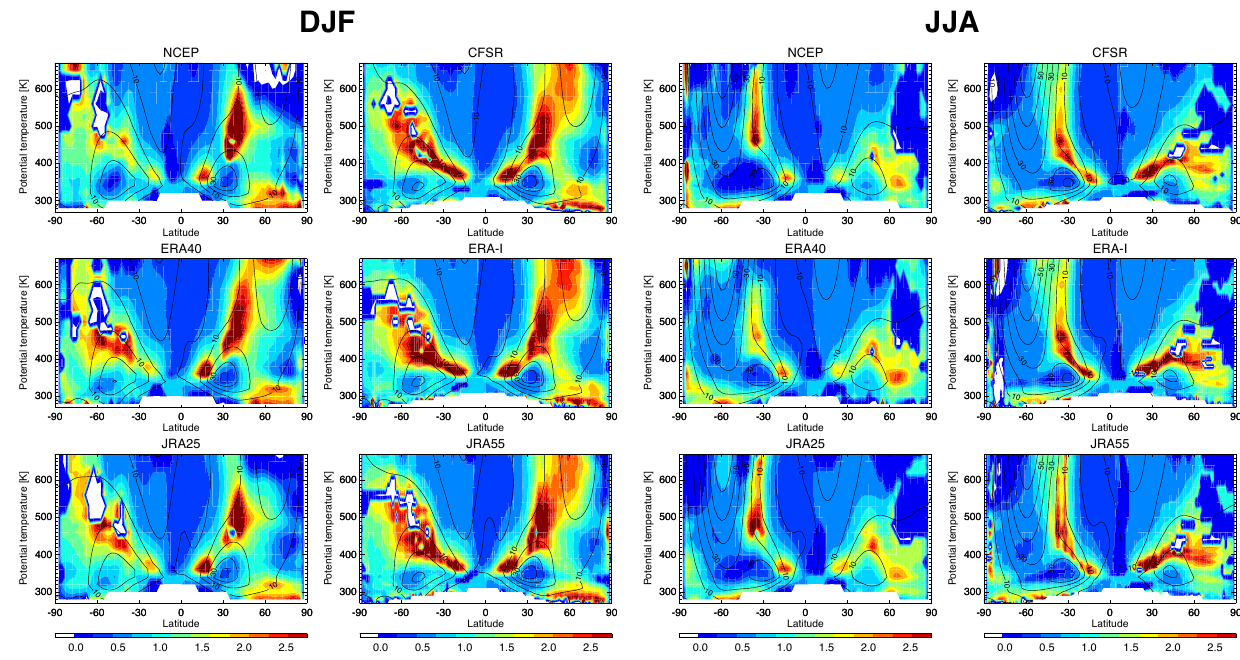
Figure 1. Latitude and potential temperature cross section of the isentropic diffusion coefficient Kyy ( l = 1 month) (in 10 6 m 2 s − 1 ) averaged for December to February (DJF, left panel) and June to August (JJA, right panel) over the time period 1979–2012 (1979–2002 for ERA-40). The results are shown for the NCEP-NCAR reanalysis (top left), NCEP-CFSR (top right), ERA-40 (middle left), ERA-Interim (middle right), JRA-25 (bottom left), and JRA-55 (bottom right) in each